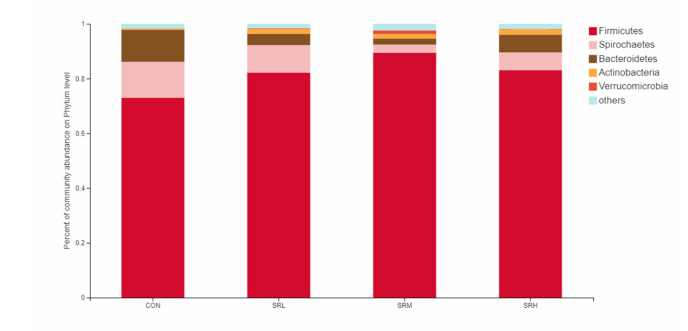
Figure 6. Histogram of the relative phyla abundances.